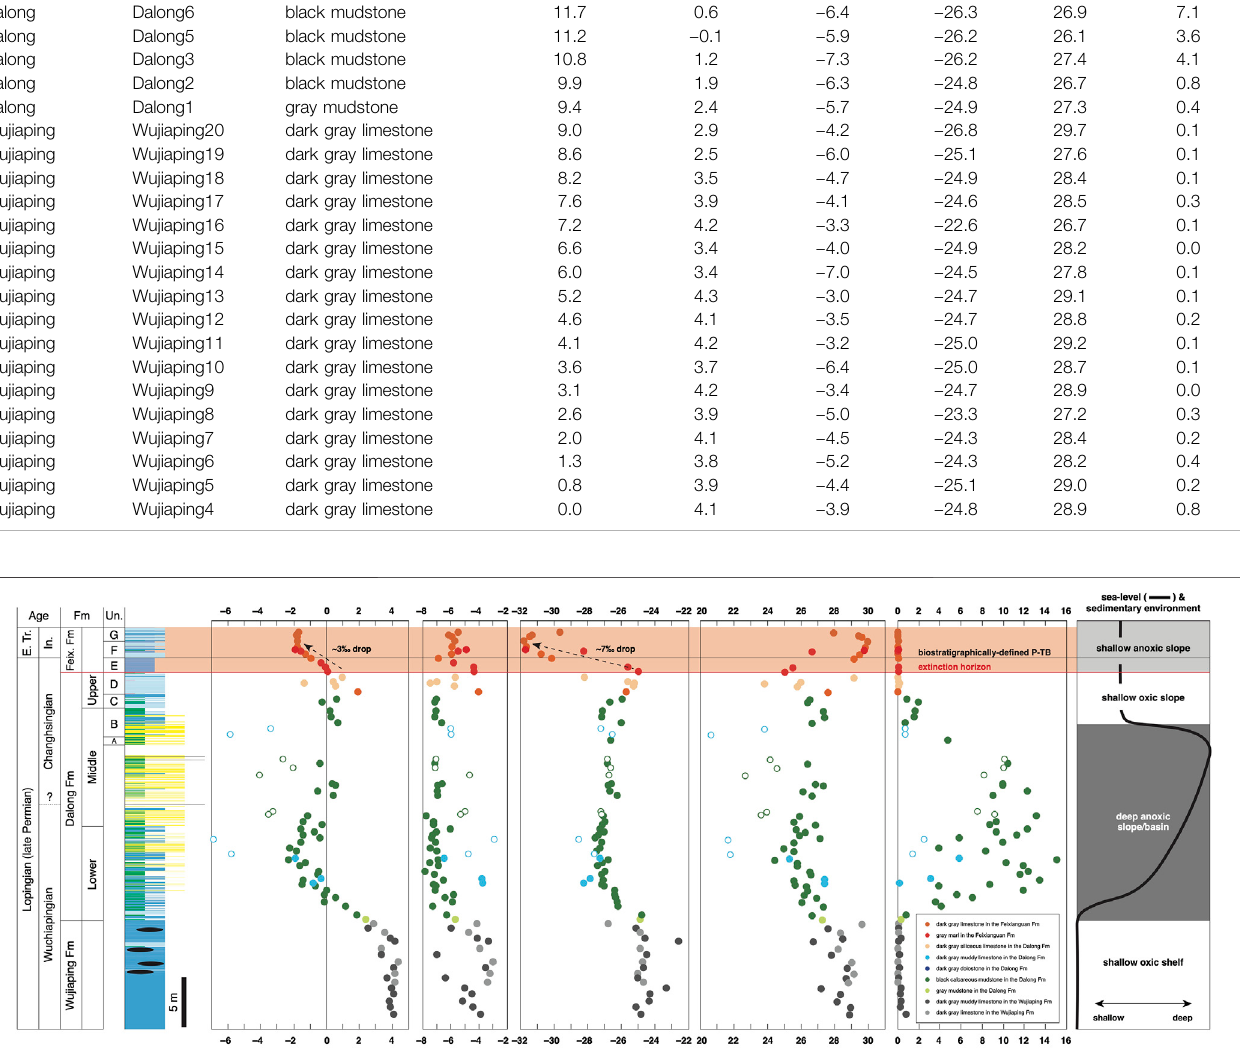
Frontiers in Earth Science |